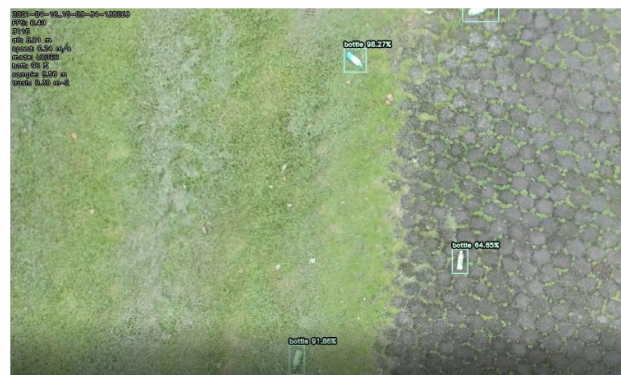
Figure 12. Real-world UAV tested on the NTOU